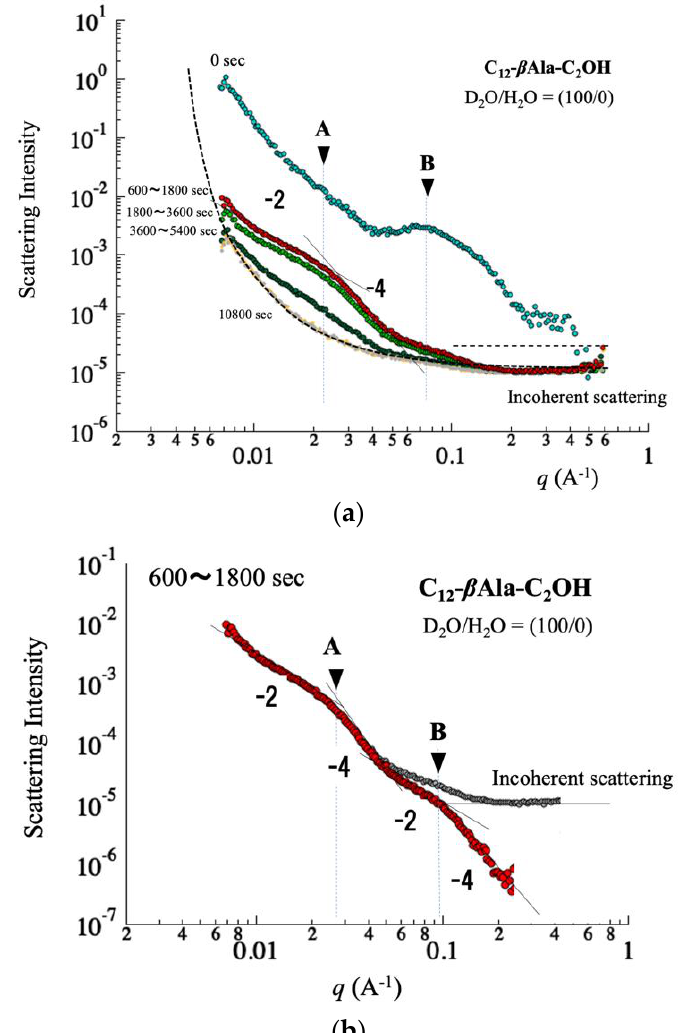
Figure 13. ( a ) Highlights of SANS for long elapsed time (3600 – 5400 s) obtained for the C 12 – EtOH – β Ala solution of 100% D 2 O. The crossover ( q ), as indicated by A, remained at 3600 s and became less obvious for 3600 – 5400 s. The broken line indicates an instrument background. ( b ) Examination of SANS observed at 600 – 1800 s. After the subtraction of incoherent scattering, second slopes of q – 2 and q – 4 (as indicated by B) appeared at around q > 0.1 A −1 . From the second q -crossover from q – 2 to q – 4 , we determined another film thickness of d = 6 nm, which was attributed to a Newton black film.